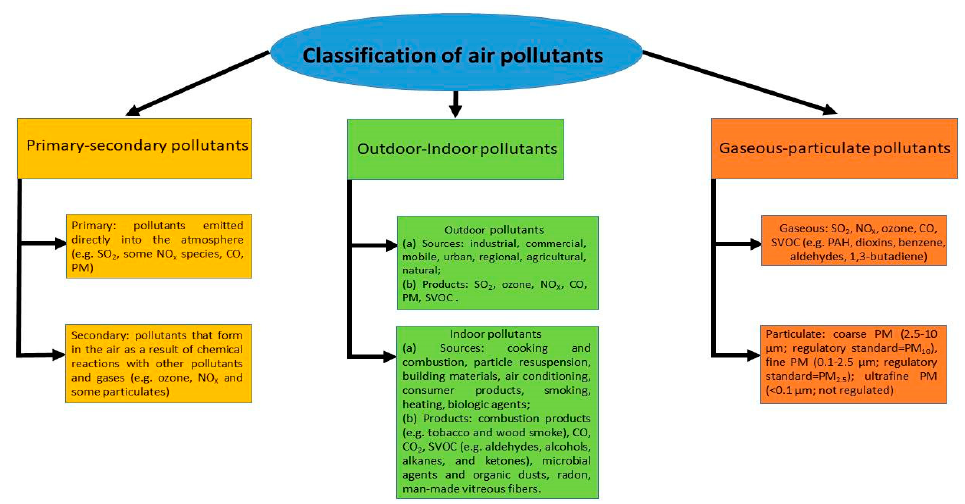
Figure 1. Classification of air pollutants (Modified from Bernstein et al. [39]).